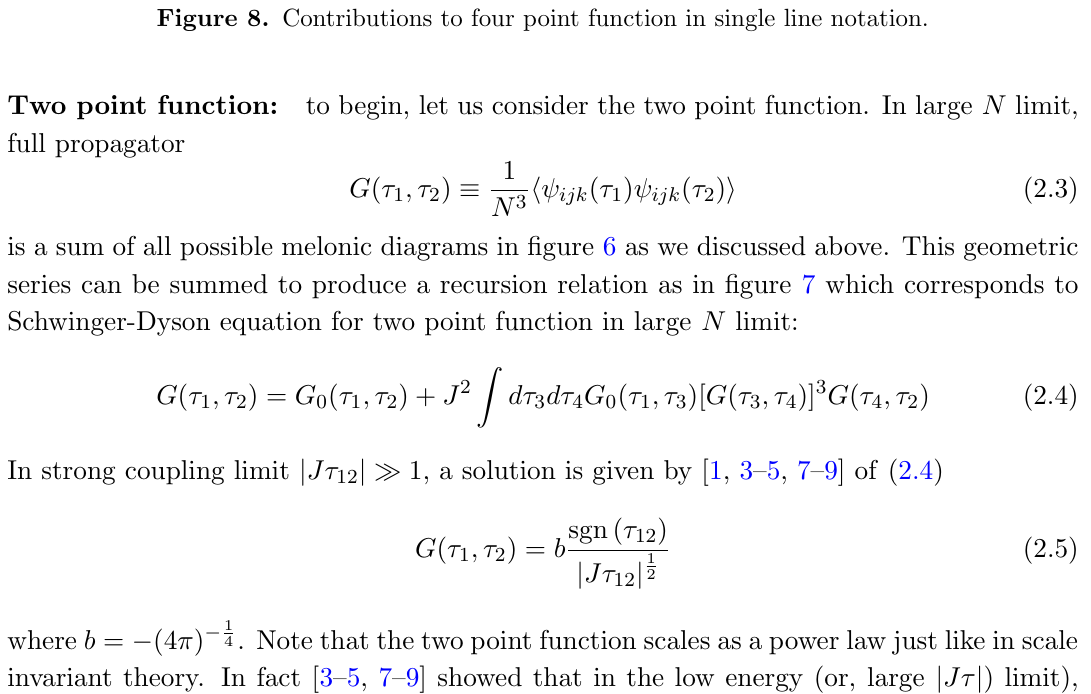
Figure 8. Contributions to four point function in single line